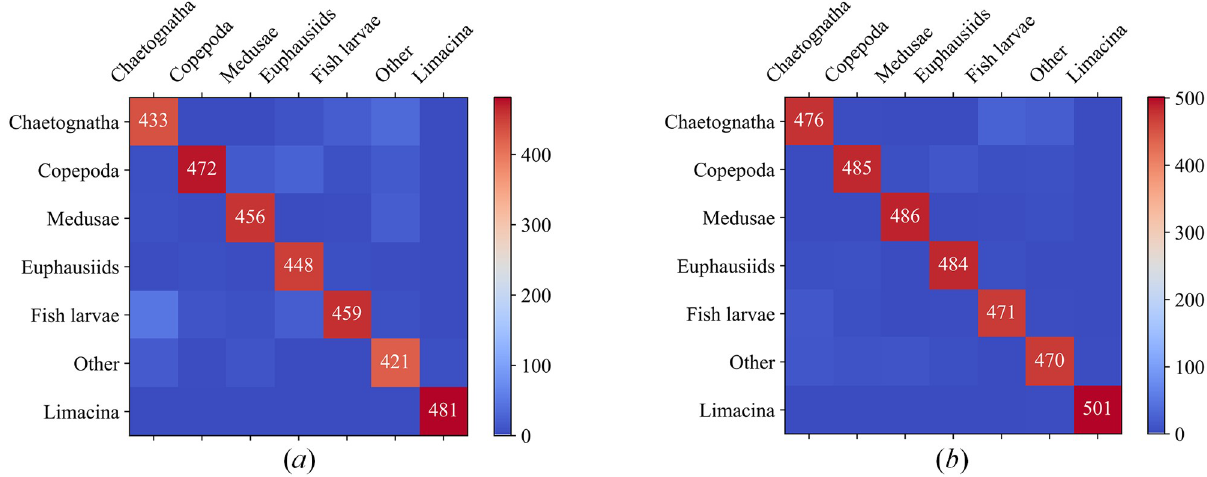
Fig 9. Confusion matrix of the final results of original ResNet50 and the selected optimal-performance model. ( a ) Confusion matrix of original finetuned ResNet50; ( b ) Confusion matrix of EnhancedROI + ResNet50-fc´ + Multi-class SVM.